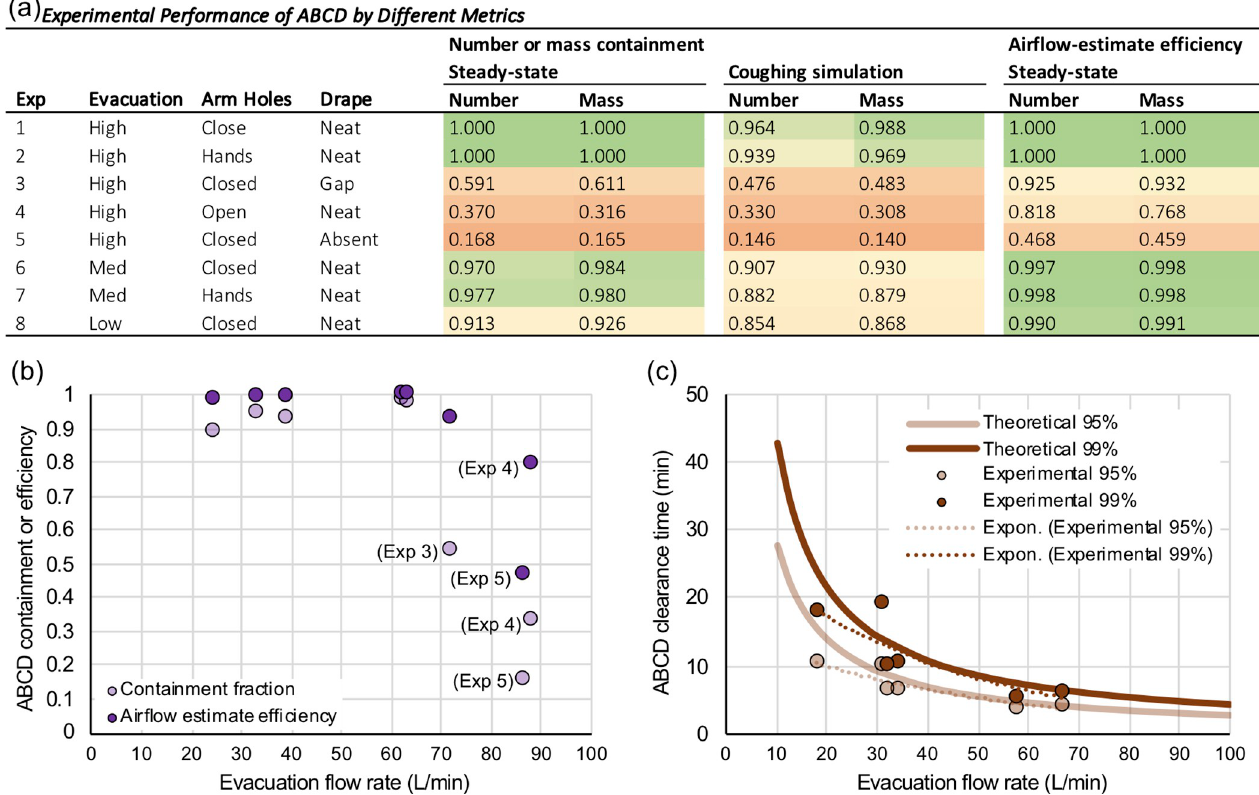
Fig 3. ABCD experimental performance. (a) Performance of ABCD during steady state phases for metrics of number or mass containment fraction [amount in ABCD / (amount in ABCD + amount in environmental chamber)] and airflow-estimated removal efficiency [ABCD evacuation flow rate / (ABCD evacuation flow rate + ABCD escape flow rate)], and during cough phase for containment fraction; (b) demonstration that reduced performance is a more function of ABCD seal properties, rather than evacuation flow rate; experiments with low containment or efficiency are noted on the plot; (c) demonstration of theoretical, experimental, and fitted ABCD clearance times (time for 95% or 99% cleared) as a function of evacuation flow rate, using data from number and mass results for Experiments 1, 6, and 8.